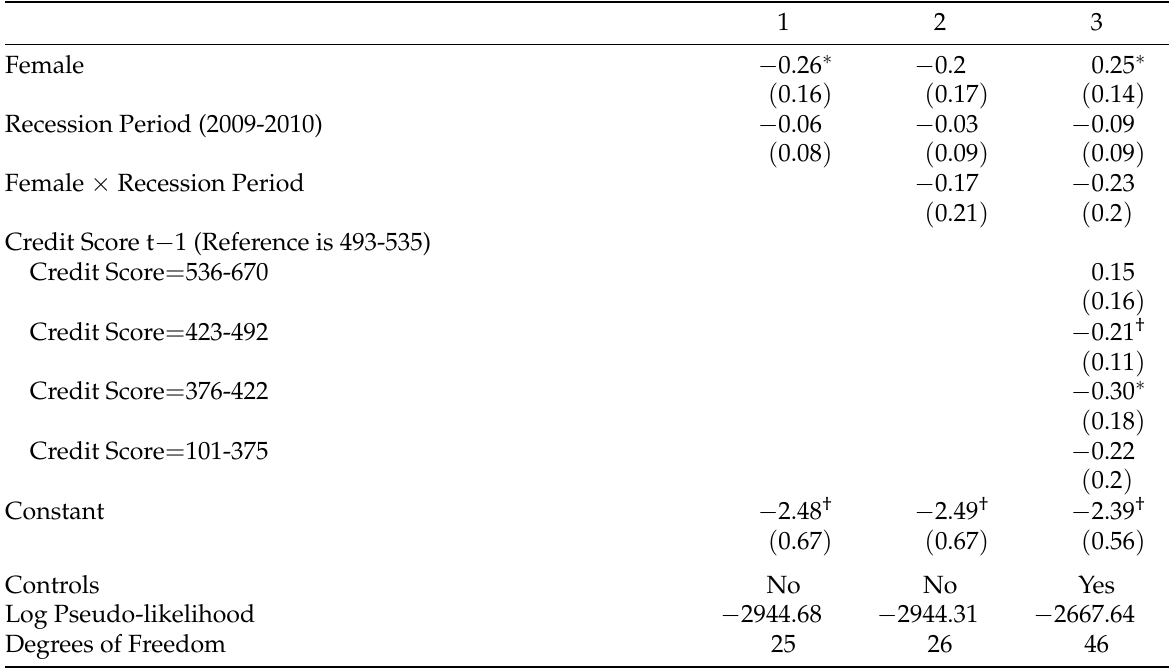
Table 2: Estimated Coefficients From Logistic Regression Models Predicting the Log Odds of Applying for a